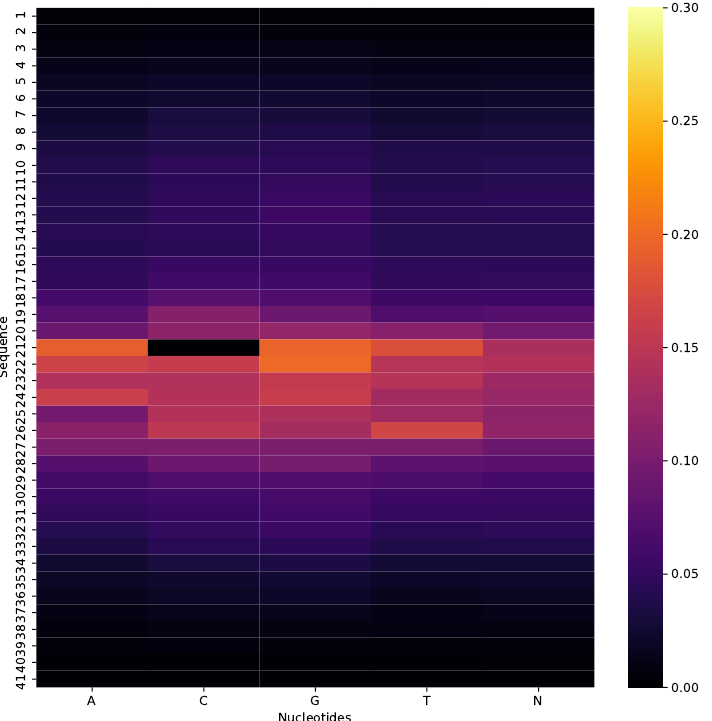
Figure 11. Heatmap visualization of silico mutation, where center of sequence with C nucleotide represents the highest effect on final prediction of Fragaria Vesca dataset.